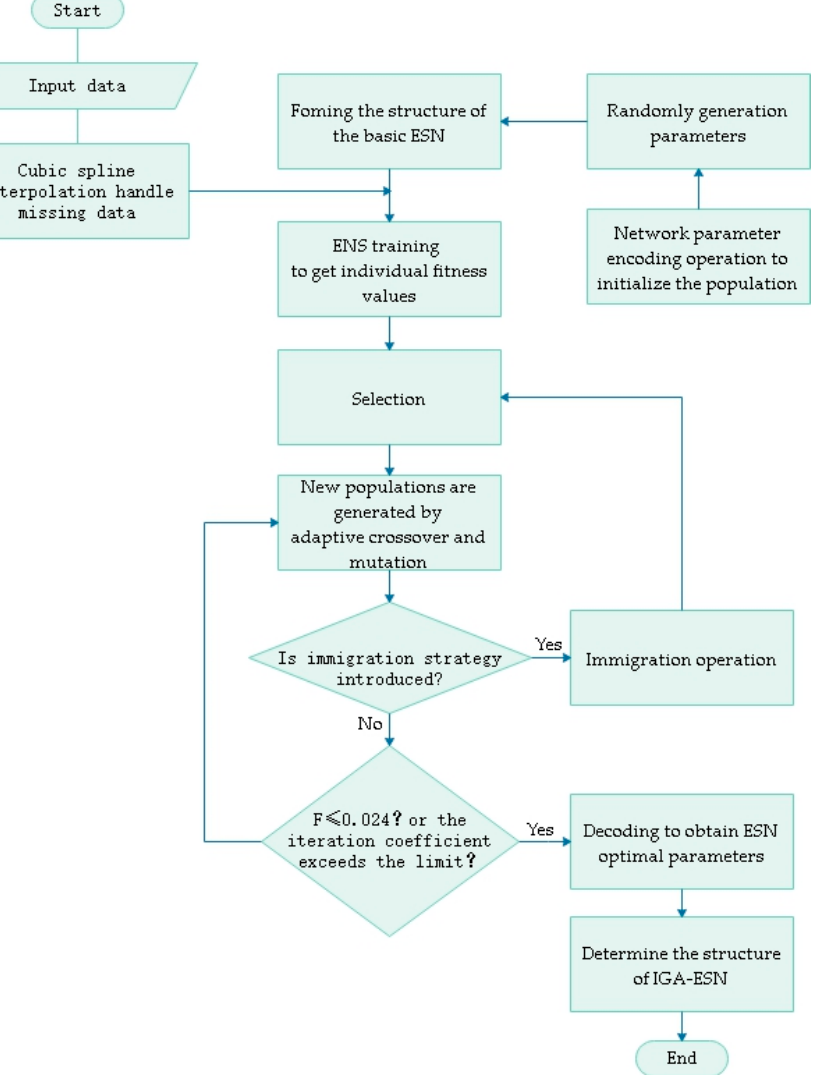
Figure 5. The development process of improved genetic algorithm optimization echo state network (IGA-ESN) soft sensor model.